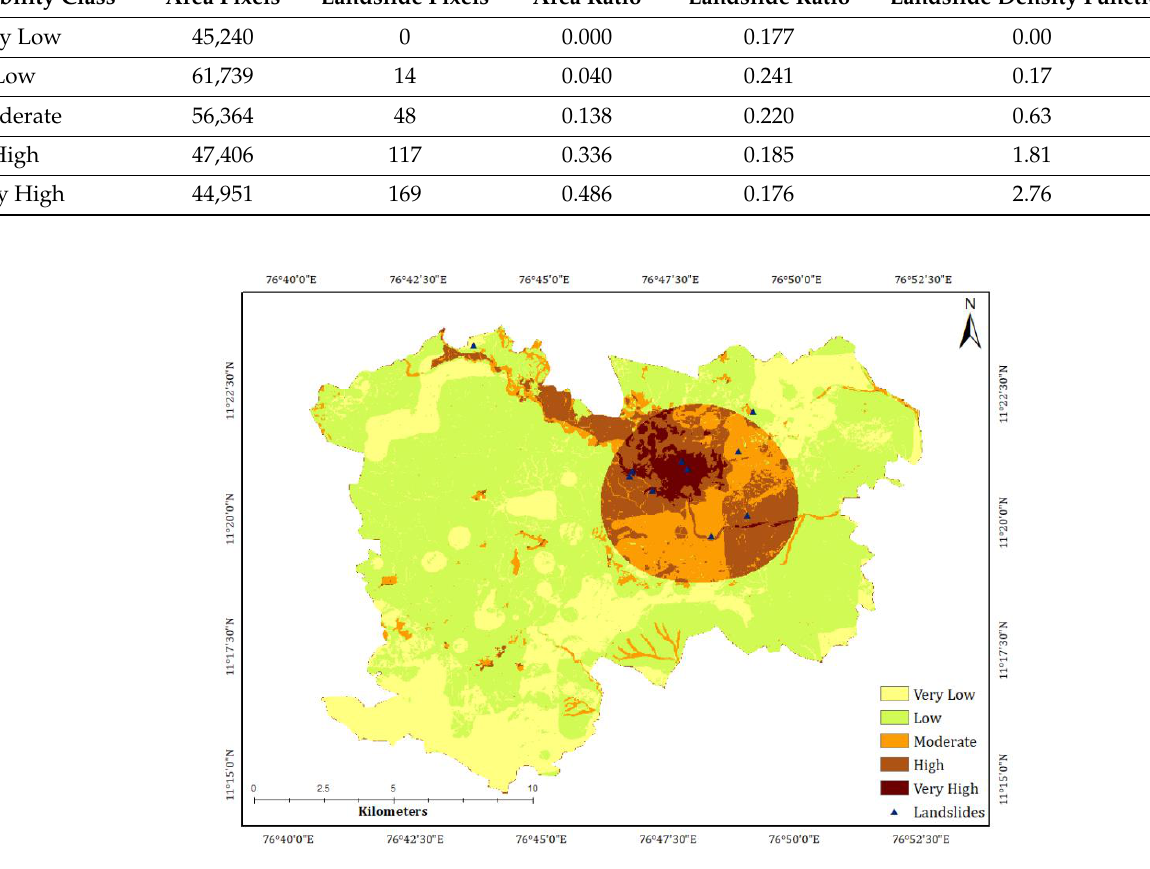
Table 5. Landslide Density Function for the Susceptibility Classes using Validation Landslide Da- taset.